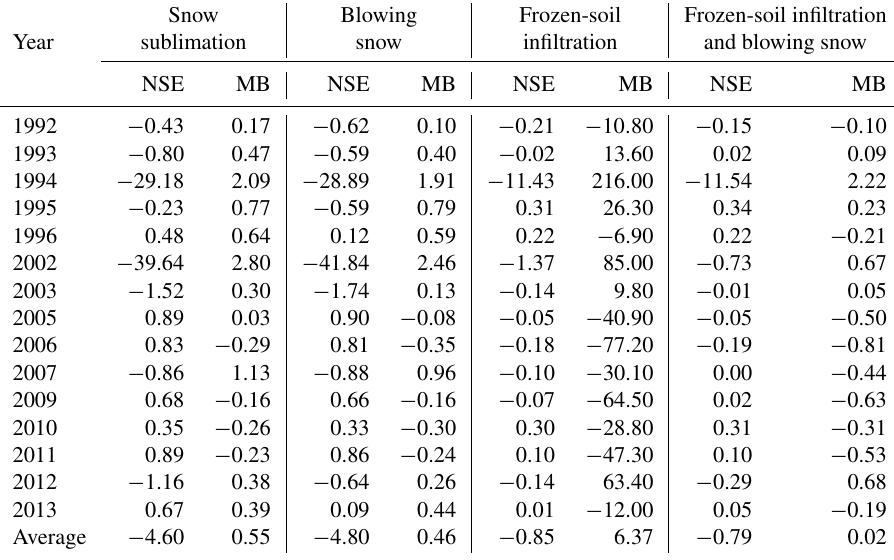
Table 6. Selected statistical metrics (i.e. NSE and model bias) for falsified models. Snow Blowing Frozen-soil Frozen-soil infiltration Year sublimation snow infiltration and blowing snow